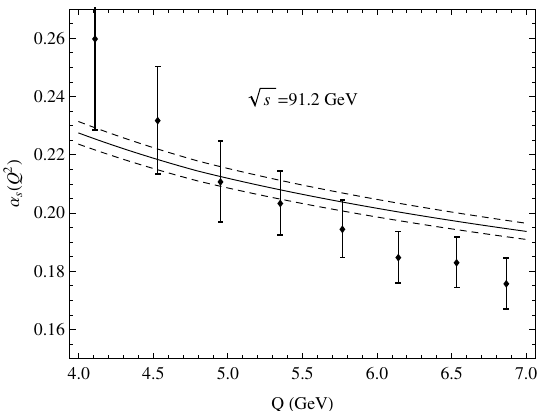
Figure 14. Similar to figure 12, but α s ( Q 2 ) extracted from the wide jet broadening ( B W ) distribu- tion.